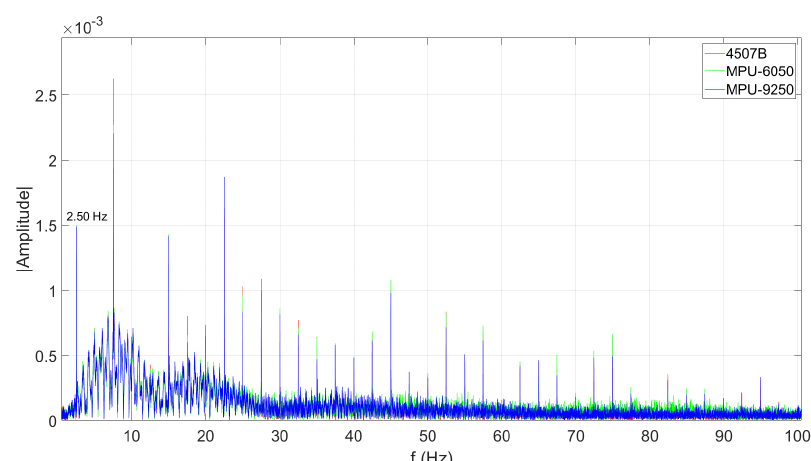
Figure 8. Responses in the frequency domain using the modulated shaker at 2,5 Hz /